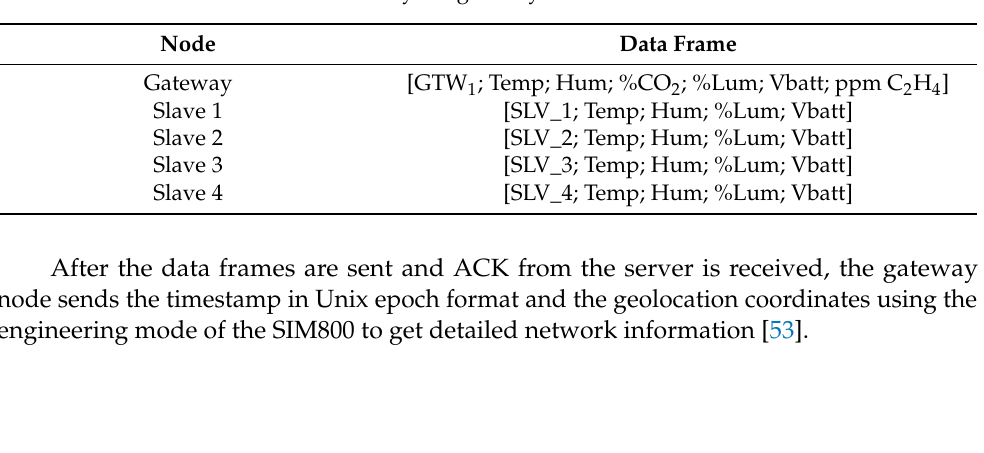
Table 1. Format of the data frames sent by the gateway node to the